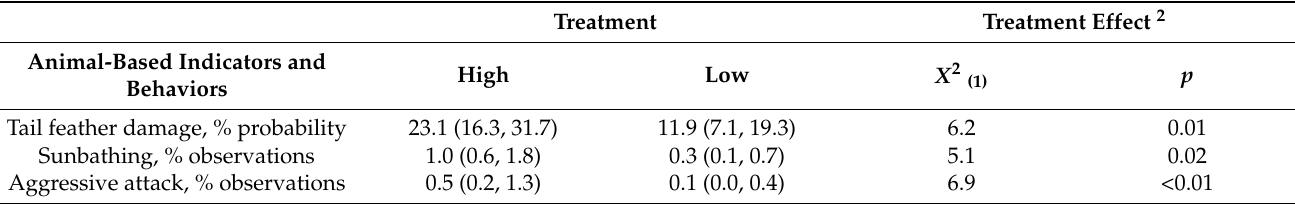
Table 4. Means ± 95% CI of animal-based indicators and behaviors affected by outdoor stocking density treatment (high: 0.5 m 2 of pasture per bird; low: 2.5 m 2 of pasture per bird) for mixed-sex Freedom Ranger chickens raised in a free-range system from 5 to 11 weeks of age 1 .